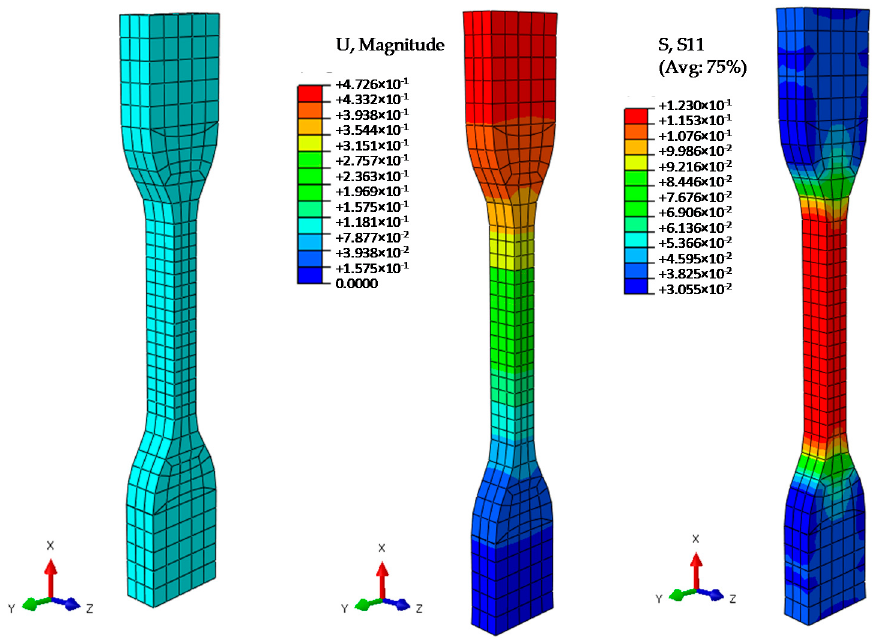
Figure 11. Finite element model and examples of the results obtained. The complete curves for each simulation V1, V2 and V3 are presented alongside with experimental results V11, V21 and V31 in Figure 12.